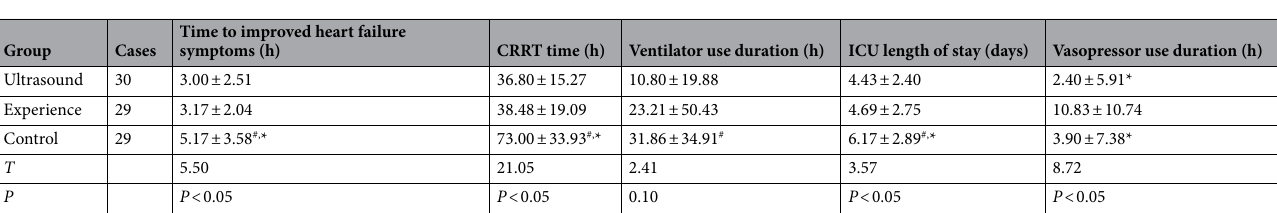
Table 4. Comparison of clinical indicators among three groups. # Statistical significance compared with the